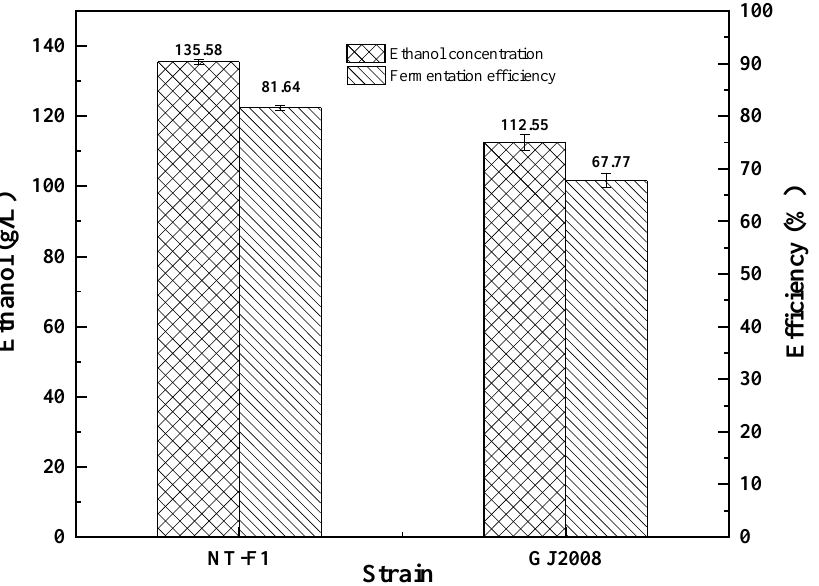
Figure 7. Comparison of ethanol fermentation capacity of mutant and non‑mutant strain. The mu‑ tant strain NT‑F1 compared with non‑mutant strain GJ2008 under 310 g/L sucrose.